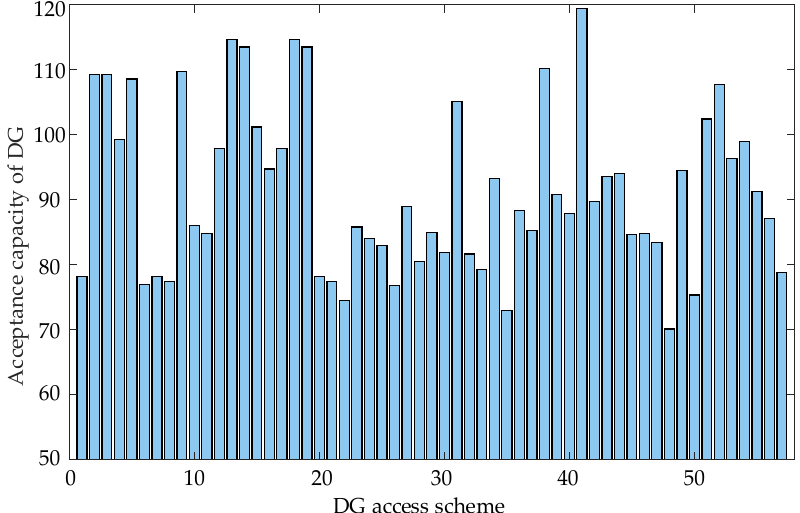
Figure 9. The total amount of DG access of each Pareto frontier solution.